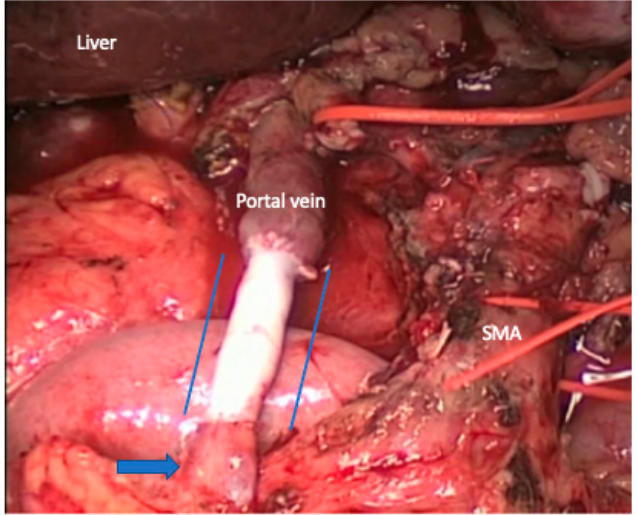
Figure 8. Type 4: segmental resection with interposed venous conduit. The spleno–portal confluent was complete resected. The blue arrow shows the superior mesenteric vein. The blue lines mark the cadaveric iliac vein interposed conduit of 6.5 cm long. SMA, superior mesenteric artery, which was clamped for 25 min to perform the venous anastomosis and avoid intestinal congestion.